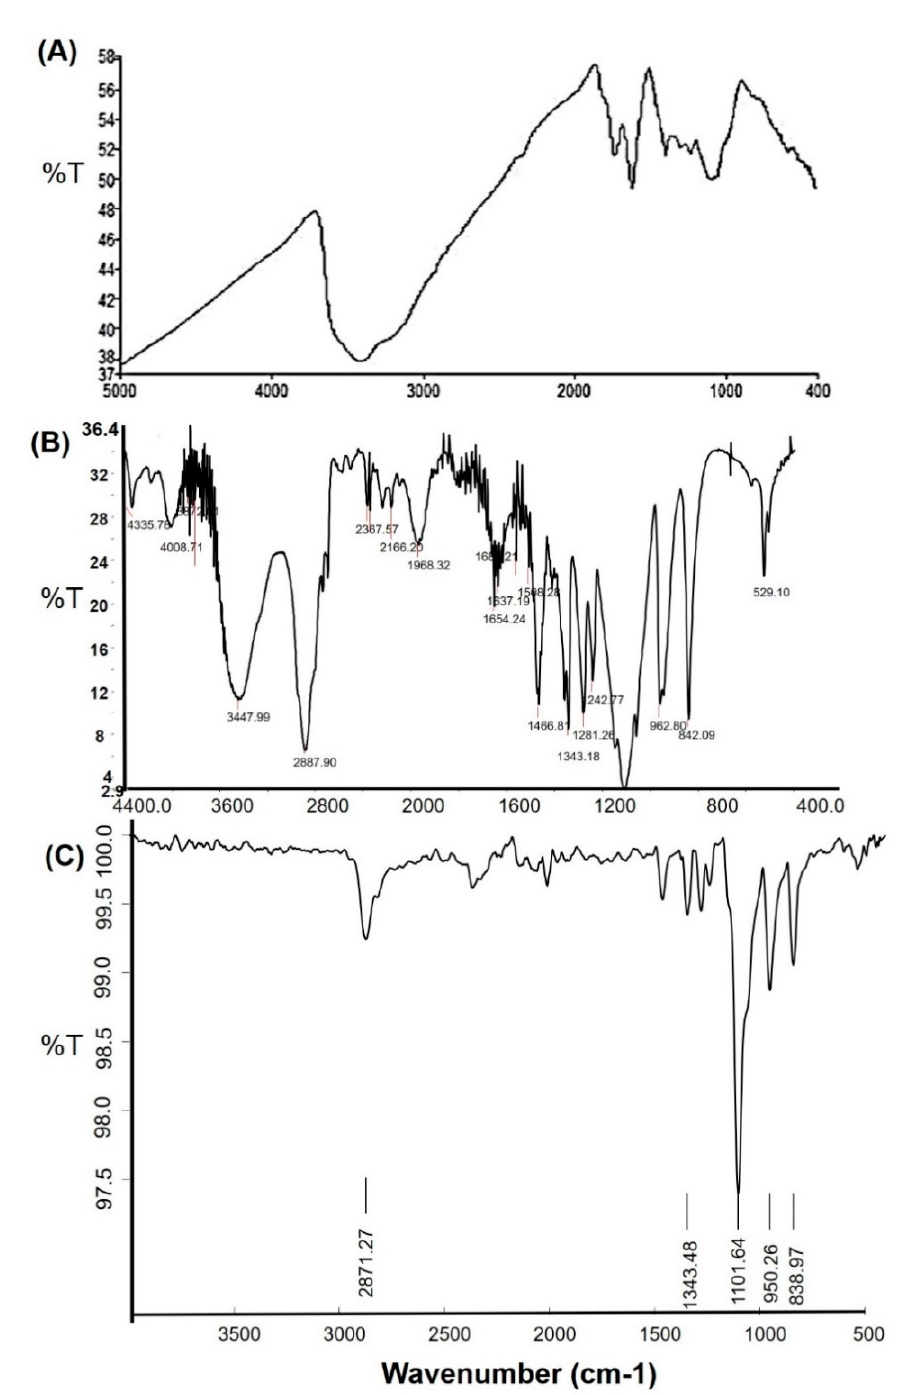
Figure 5. Fourier transform infrared (FTIR) spectra of ( A ) GO, ( B ) PEG 6000 and ( C ) PEGylated NGO.